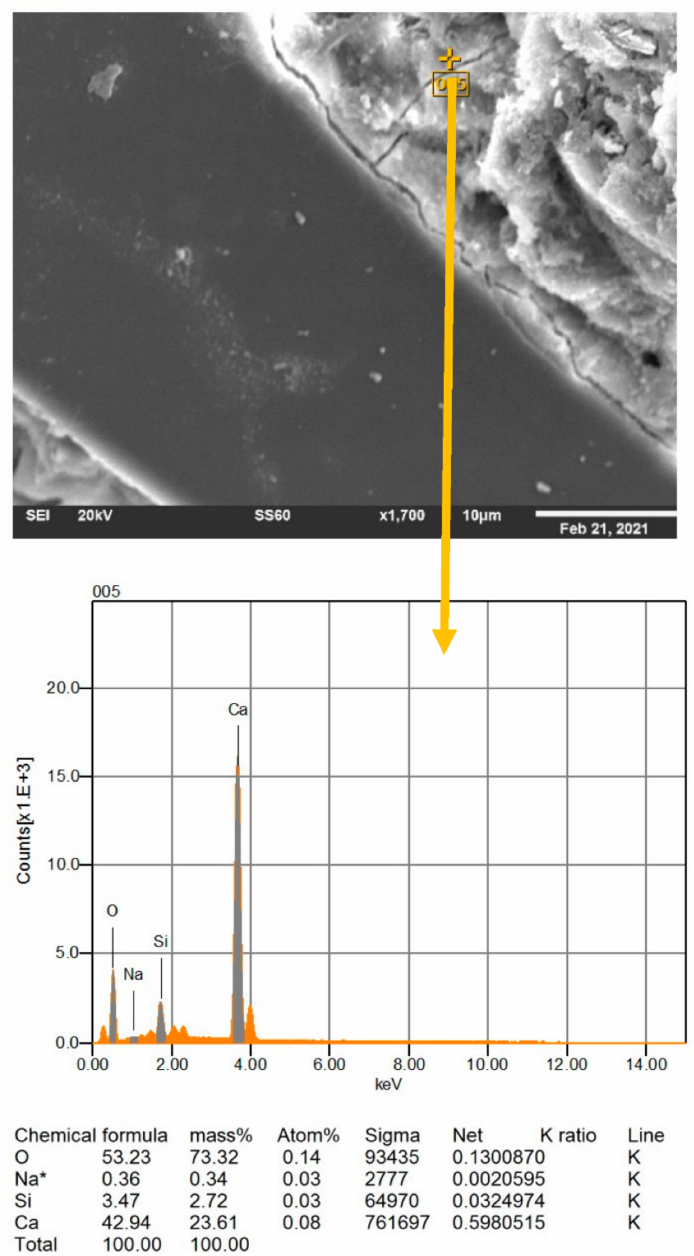
Figure 18. Glass-mortar interfacial zone with ASR cracking. The accompanying EDS point probe indicates that the Na-Si-Ca ratio is consistent with compositions of ASR in lime